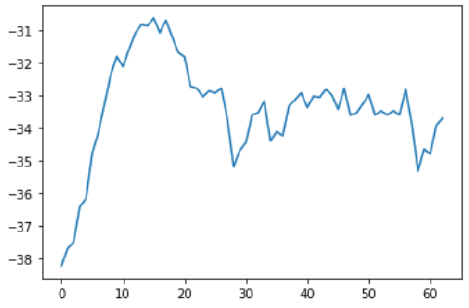
Figure 17. Magnetometer x -axis noise (CCIS/KSU).